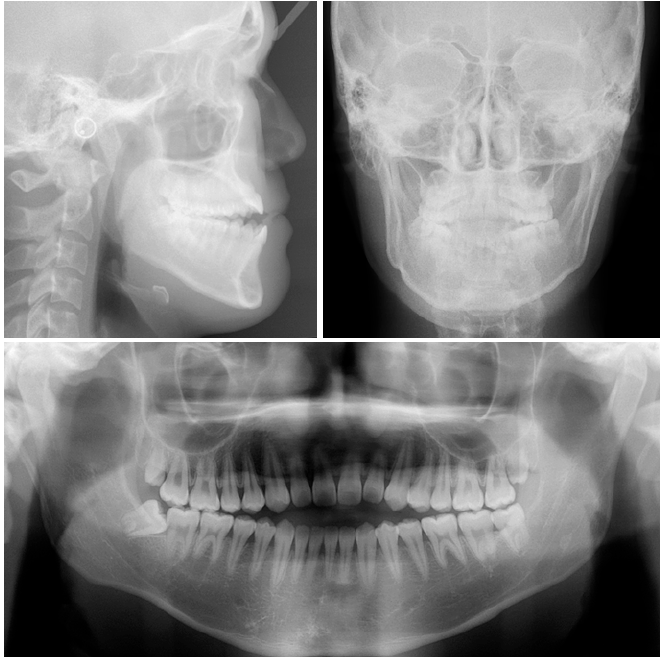
Figure 3. Pretreatment radiographs.